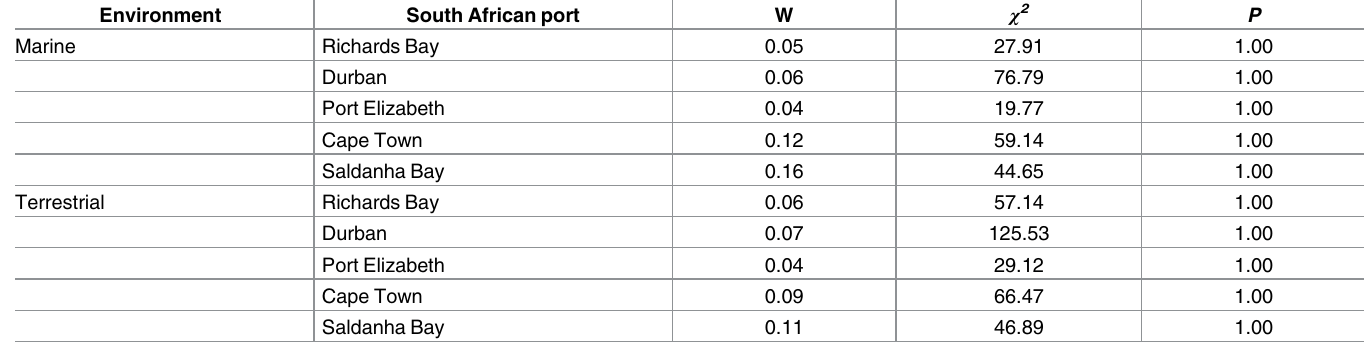
Table 3. Seasonal concordance for each South African port. A significantresult wouldindicate that the route ranking for at least one season is concor- dant with another, but as none were significant,the seasonalroute rankings for all South African ports are not concordant with one another.